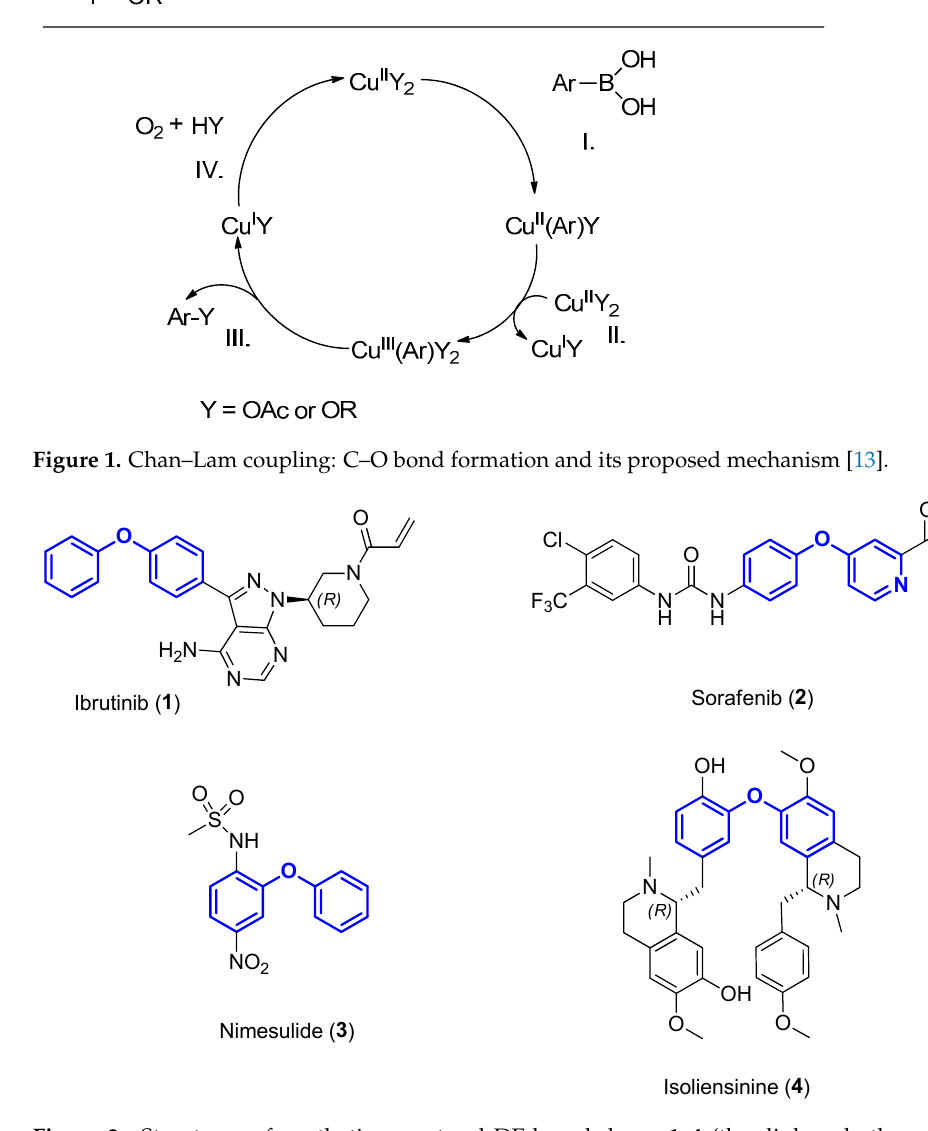
Figure 2. Structures of synthetic or natural DE-based drugs 1 ‒ 4 (the diphenyl ether moiety is high- lighted in blue). highlighted in